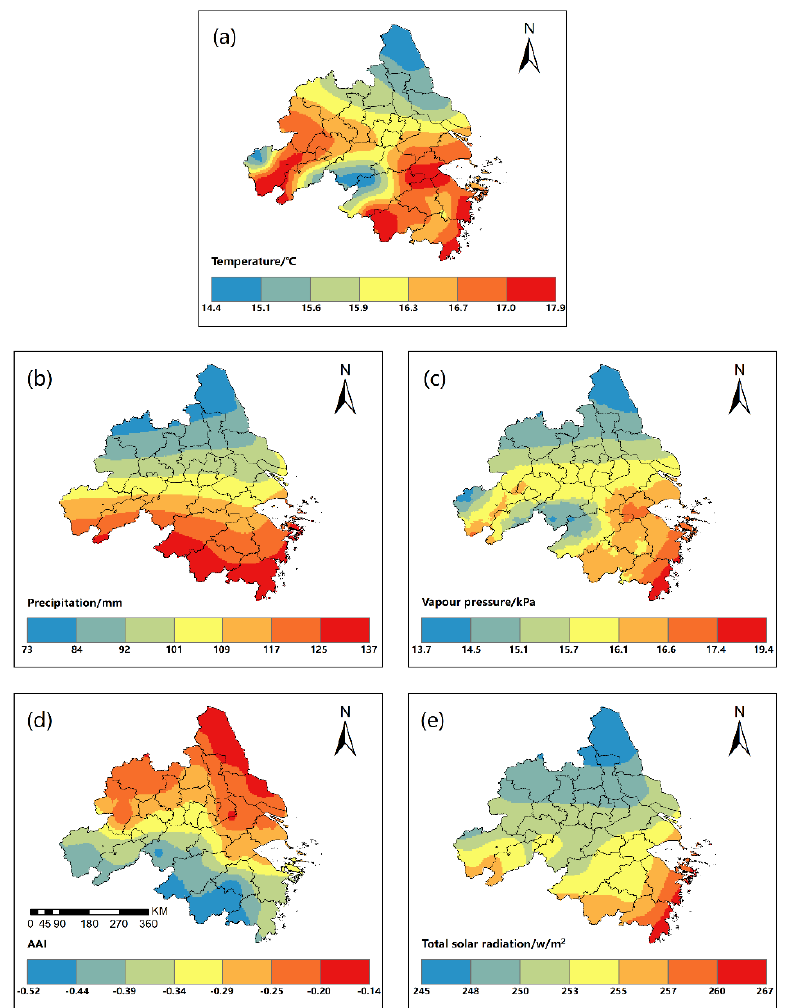
Figure 4. The spatial distribution of the 20-year average values of the meteorological factors of temperature ( a ) precipitation ( b ) vapor pressure ( c ) AAI ( d ) and total solar radiation ( e ) over the Yangtze River Delta Urban Agglomerations during 2000 – 2019. Table 1. The correlations in the annual variation between the TCO and different meteorological factors.